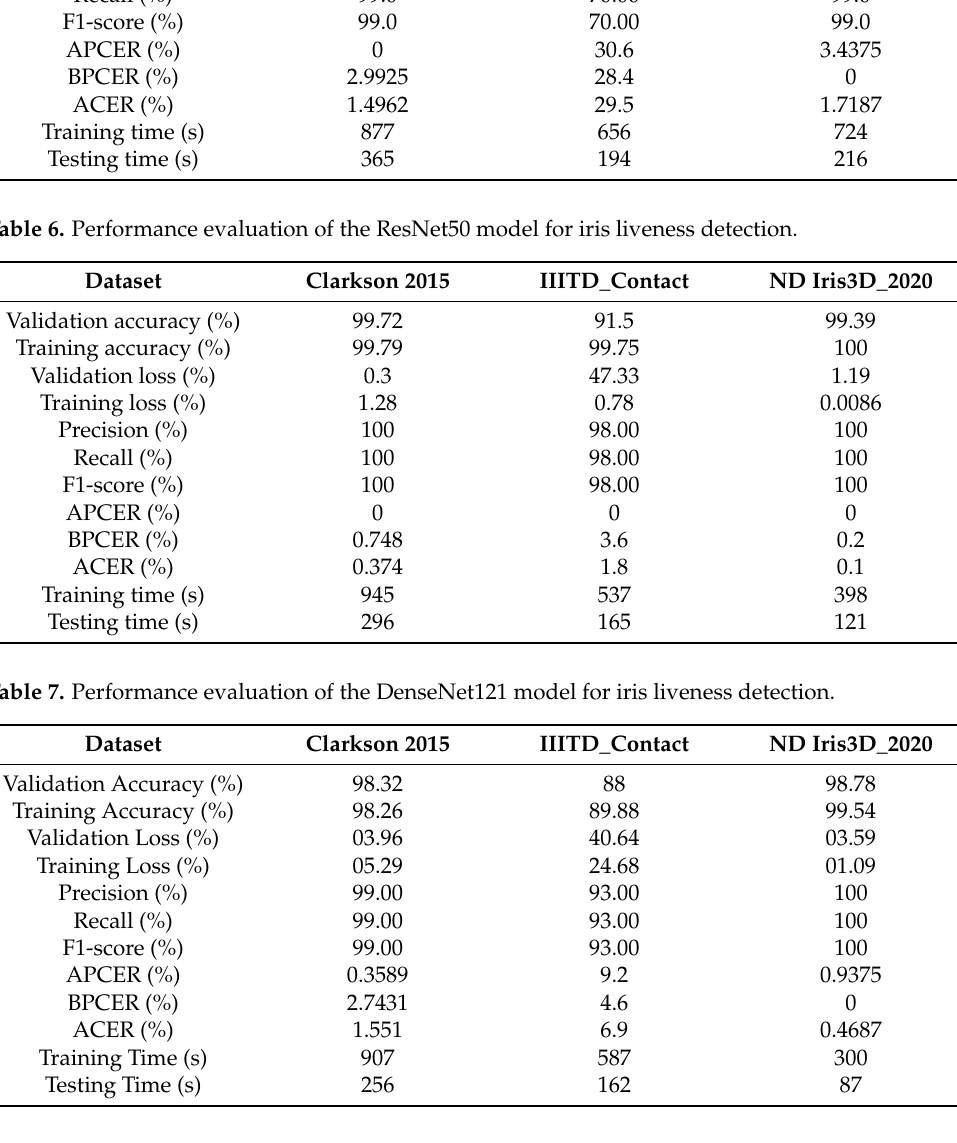
Table 8. Performance evaluation of the EfficientNetB7 model for iris liveness